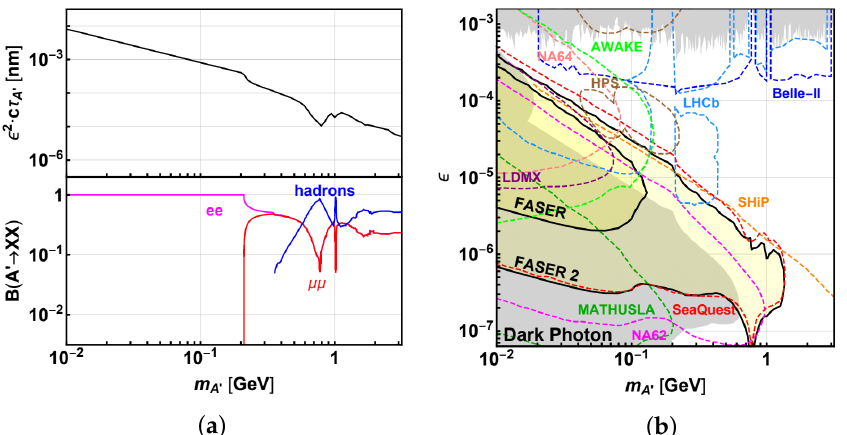
Figure 1. ( a ) Dark photon decay modes according to mass range. ( b ) FASER and FASER2 (proposed, enlarged successor of FASER) accessible parameter space compared with current and proposed experiments [3].